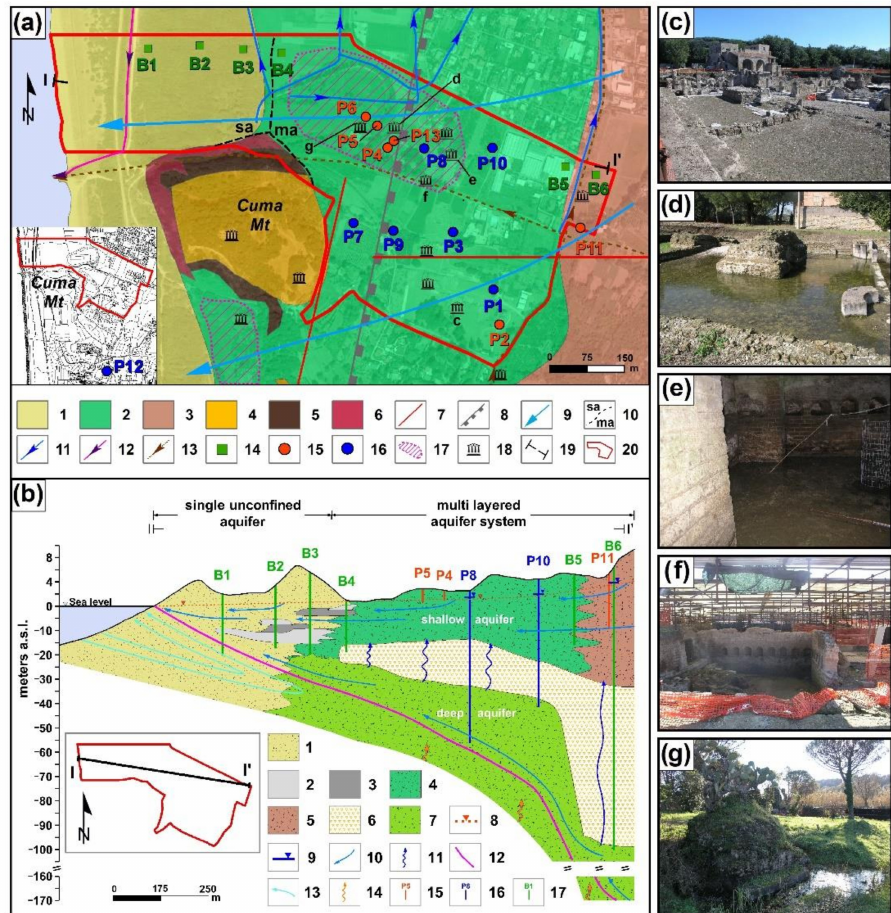
Figure 2. ( a ) Geological map of study area and hydrogeological monitoring network. Legend: (1) Eolian deposits; (2) Pyroclastic-fluvio-palustrine deposits; (3) Pyroclastic deposits; (4) NYT; (5) Museum Breccia formation; (6) Cuma Mt lavas; (7) buried fault; (8) CI caldera boundary; (9) groundwater flow direction; (10) single unconfined aquifer (sa) and multilayered aquifer system (ma) sectors; (11) groundwater draining channel; (12) Cuma plant discharge channel; (13) underground wastewater channel; (14) borehole; (15) shallow well; (16) deep well; (17) groundwater flooding (GF) area; (18) archaeological site of Necropolis (GF impacted in ( d – g )); (19) trace of hydrostratigraphic section; (20) study area. ( b ) 2D hydrostratigraphic model of the aquifer system. (1) Dune complex; (2) silts; (3)claysandpeatydeposits; (4)pyroclastic-alluvial-lacustrine(PAP)complex; (5)pyroclastic(P)complex; (6) tu ff aceous aquitard (YT) aquitard; (7) pyroclastic deposits (DPs) complex; (8) piezometric level of shallow unconfined aquifer; (9) piezometric level of deep semiconfined aquifer; (10) groundwater flow direction; (11) vertical groundwater flow direction; (12) Fw-Sw interface; (13) saline groundwater flow; (14) high mineralized fluids rising; (15) shallow well; (16) deep well; (17)